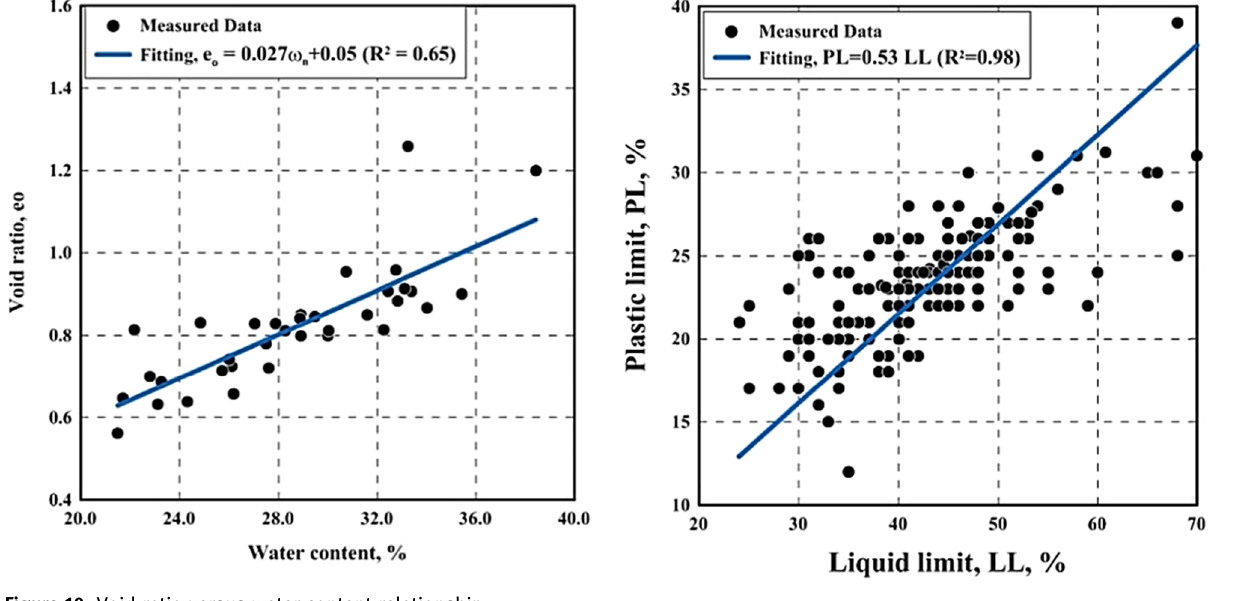
Figure 12: PL versus LL relationship.